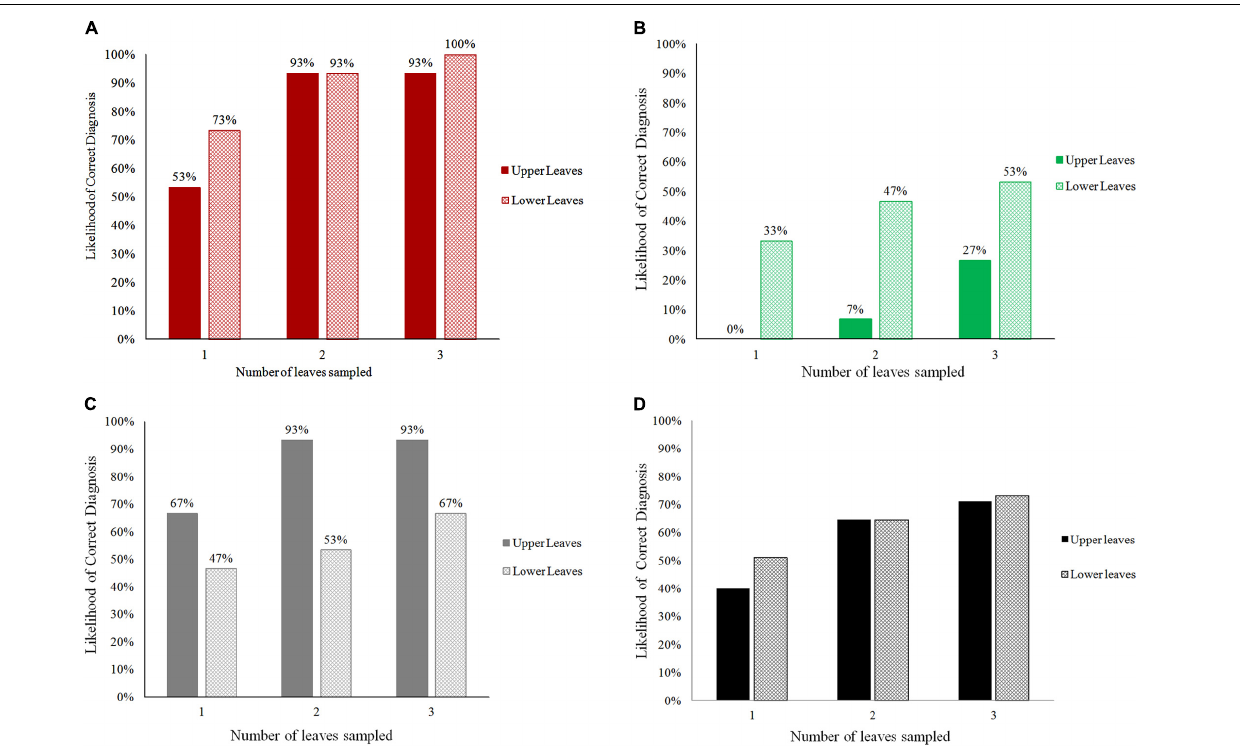
FIGURE 1 | The overall likelihood of obtaining correct diagnoses for CMD (A) , CBSD (B) , CGM-damage (C) , and all conditions (D) when using the cassava AI Nuru based on the number and position (upper or lower) of leaves sampled from 90 cassava plants.